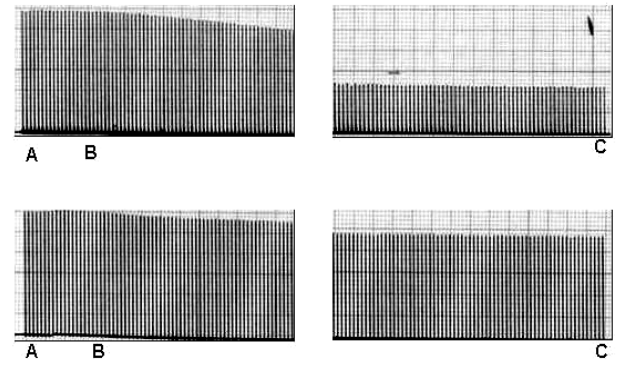
FIGURE 2 - Effect of rocuronium (4µg/mL) in muscular responses to indirect stimulation of in vitro phrenic nerve-diaphragm preparation of rats not exposed (n=5) (upper tracing-neuromuscular blockade of 60%) and previously exposed (n=5) to phenobarbital - 20mg/kg (lower tracing-neuromuscular blockade of 20%)). A = stimulation beginning; B = rocuronium addition; C = 60 minutes of stimulation